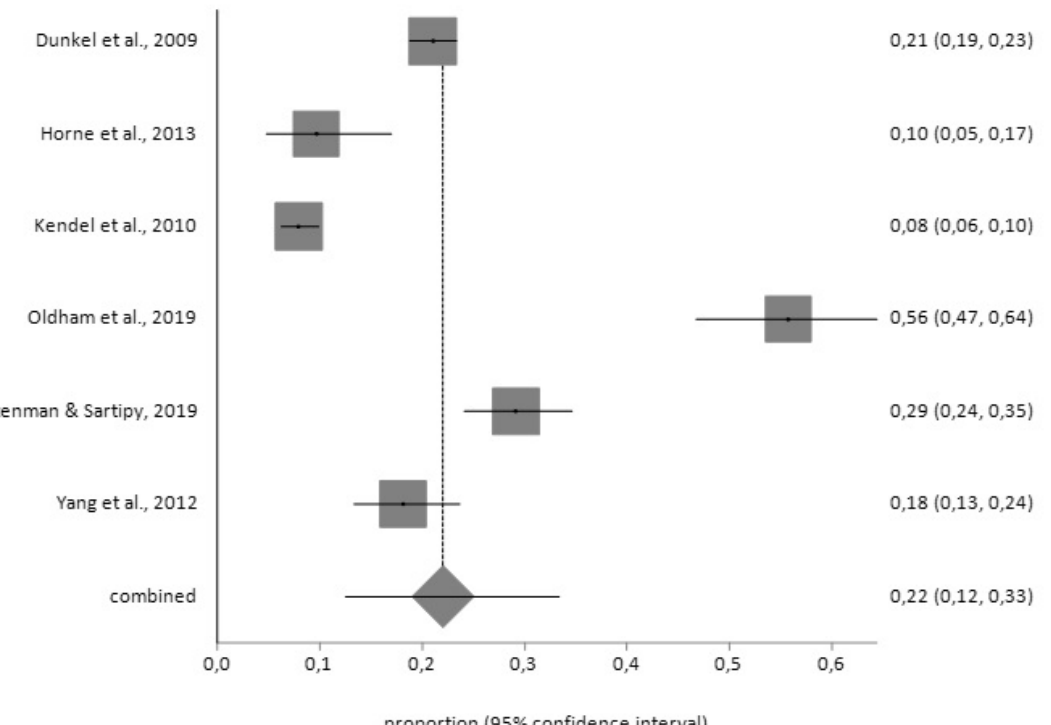
Figure 5. Forest plot for post-CABG depression using BDI.